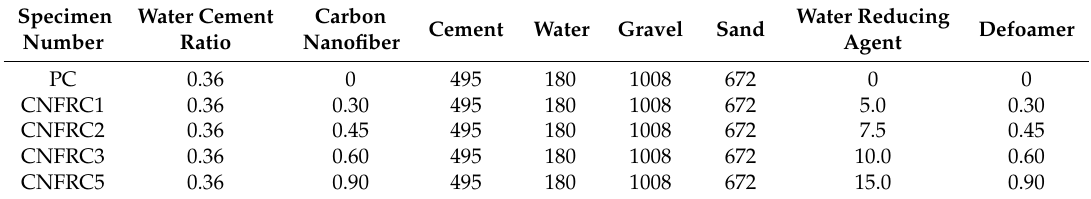
Table 1. Mix proportion of carbon nanofiber reinforced concrete (kg / m 3